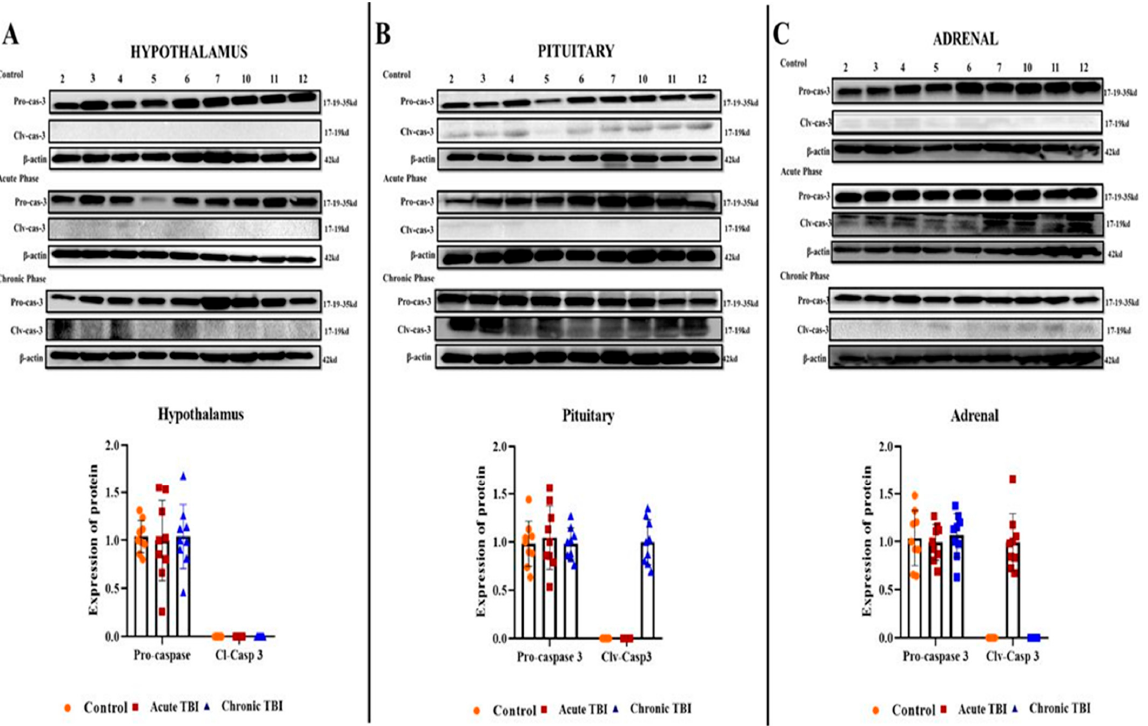
Figure 3. Western blot images of Clv-caspase-3 in the acute and chronic phase after TBI in the hypothalamus, pituitary, and adrenals. ( A ) Clv-caspase-3 protein levels in the hypothalamus after TBI in the acute, chronic, and control groups. ( B ) Clv-caspase-3 protein levels in the pituitary after TBI in the acute, chronic, and control groups. ( C ) Clv-caspase-3 protein levels in the adrenals after TBI in the acute, chronic, and control groups. β -Actin was used as a loading control (n = 9 rats in each group). All experiments were independently repeated at least